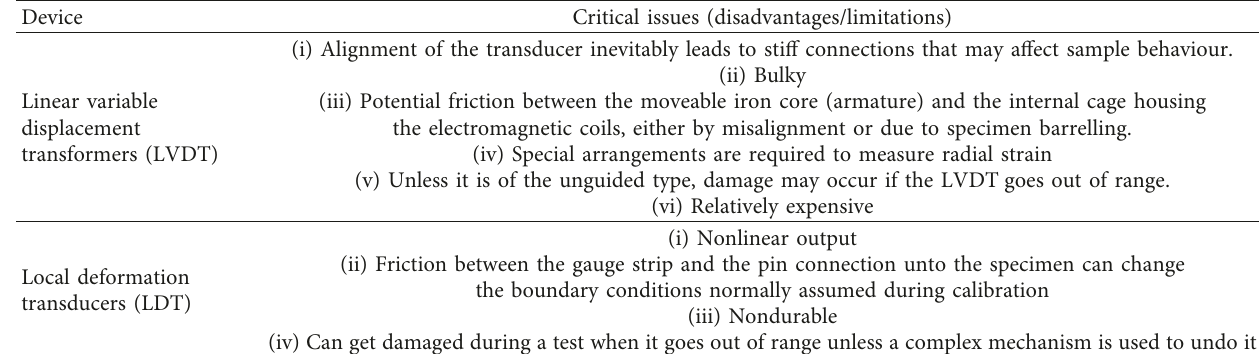
Table 1: Issues associated with LVDTs and LDTs.